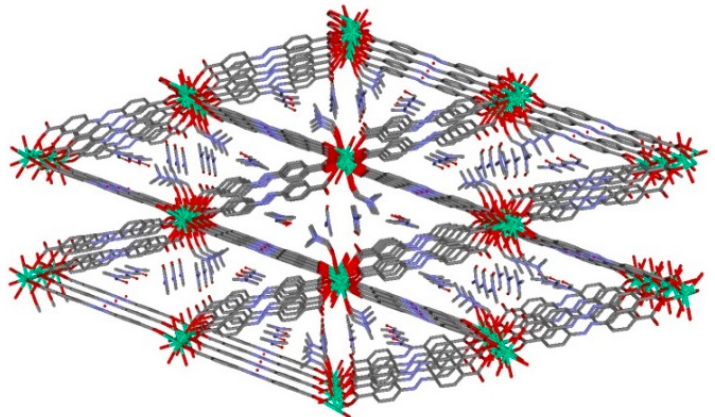
Figure 2. View down a axis of channels in MOF 1 . Hydrogen atoms have been omitted for clarity. Color code N = blue, O = red, C = grey, Tb = green.